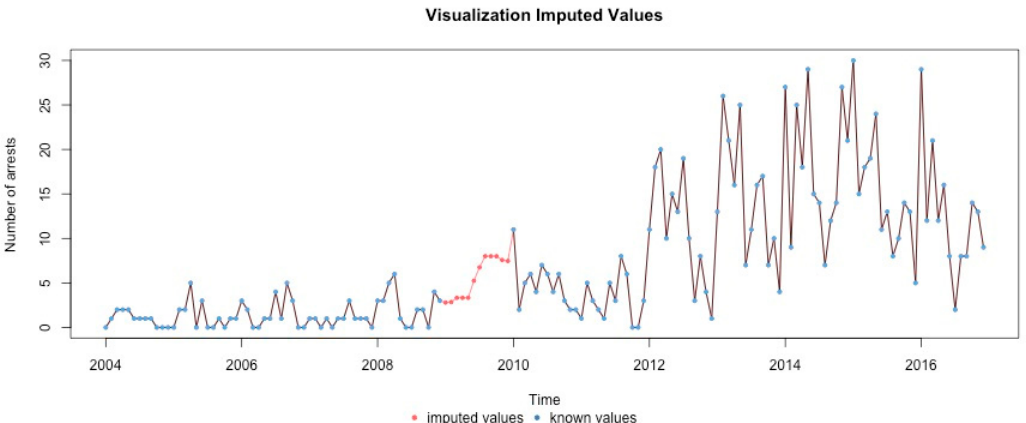
Figure A6. Precursor arrests 2004–2016 in the Czech Republic – imputed missing values.